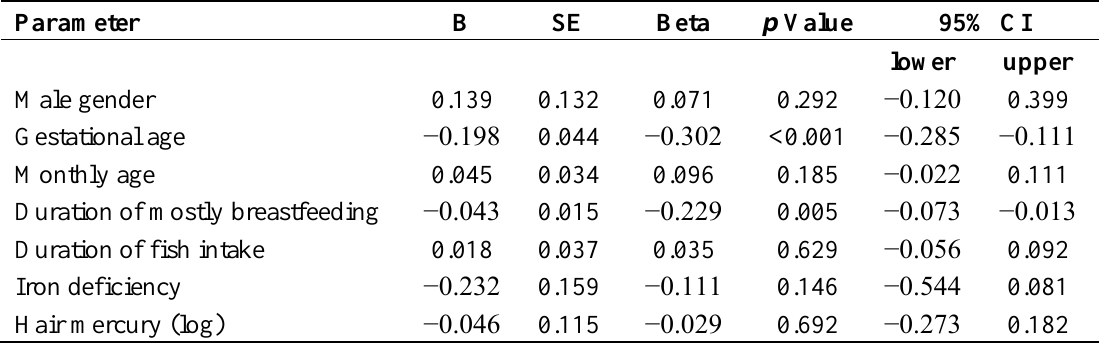
Table 4. Multiple regression analysis of the difference of weight percentiles (WAZ-BWZ) in 252 infants according to possible growth-related factors including hair mercury